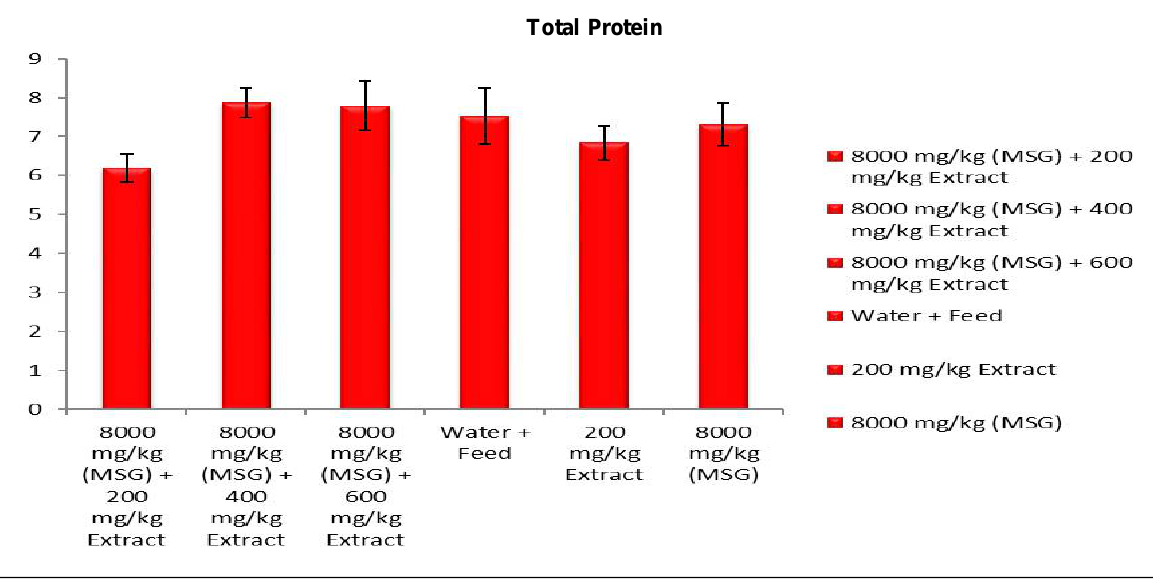
Figure 4: Effect of methanol extract of N. laevis on total protein concentration (mg/dl) of female albino